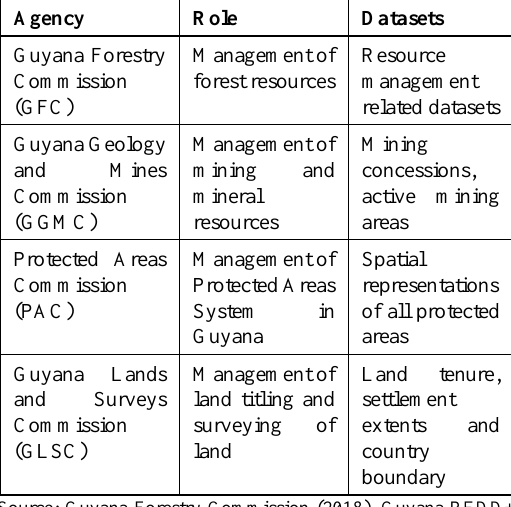
Table 3- Primary agency datasets incorporated in